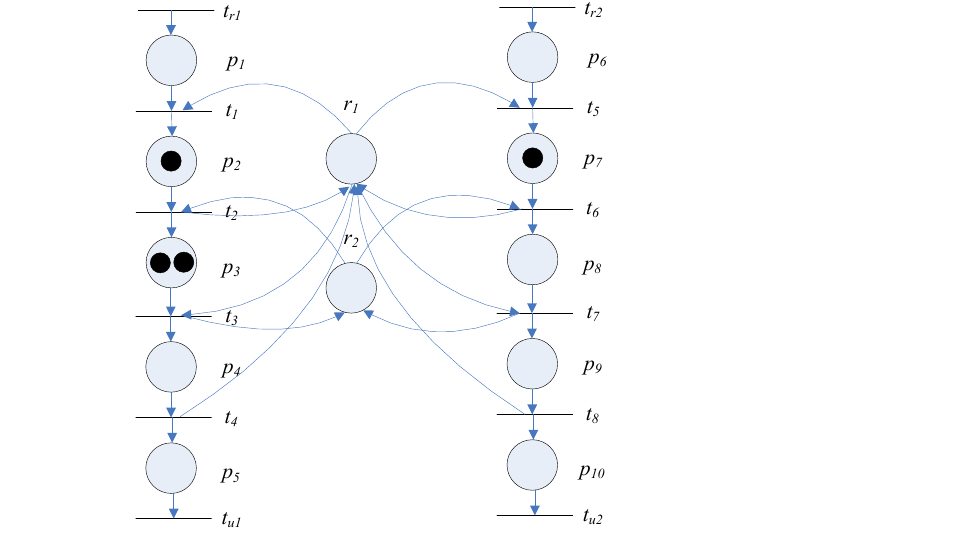
Figure 4. An undesirable state in which the two types of resources are in a circular waiting situation and a subset of transitions can no longer be fired.